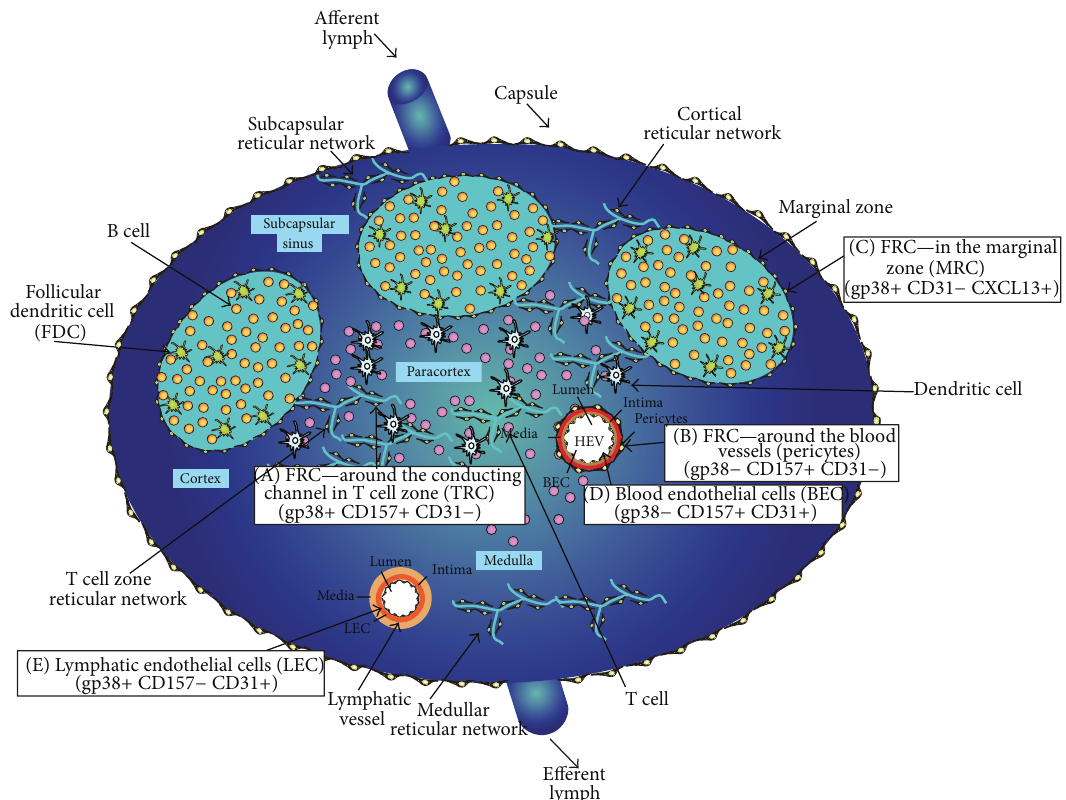
Figure 2: Schematic representation of lymph node and cells classification [4–6]: (A) FRC in the T cell zone (TRC) − gp38+ CD157+ CD31 − . (B) FRC around blood vessels (pericytes) gp38 − CD157+ CD31 − . (C) FRC in the marginal zone (MRC) gp38+ CD31 − CXCL13+. (D) Blood vessel endothelial cells (BEC) gp38 − CD157+ CD31+. (E) Lymphatic endothelial cells (LEC) gp38+ CD157 − CD31+